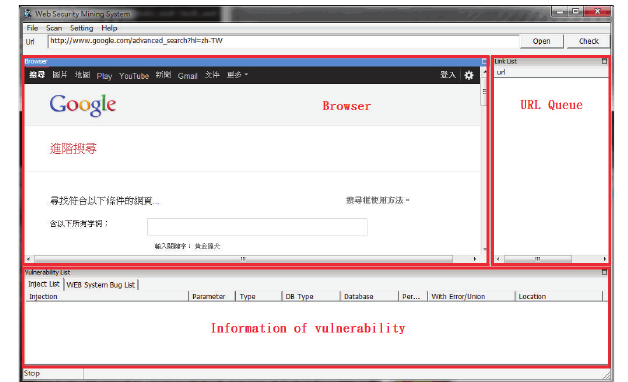
Figure 2: Crawler mining system interface.